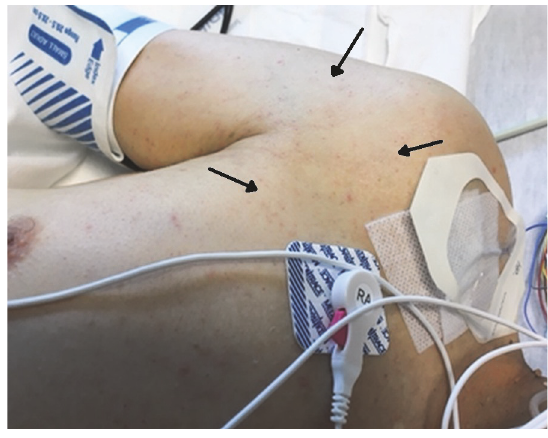
Figure 4: Anterior chest wall petechial rash (black arrows).